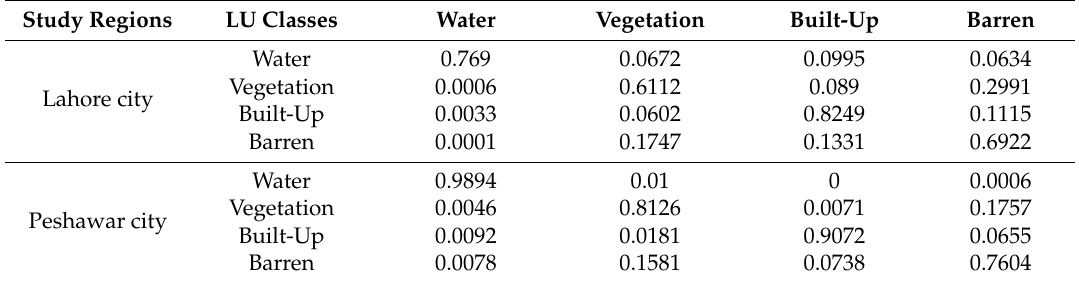
Table 5. Transition probability Matrix for different land use classes from 2003 to 2008 in Lahore (top) and Peshawar (bottom).